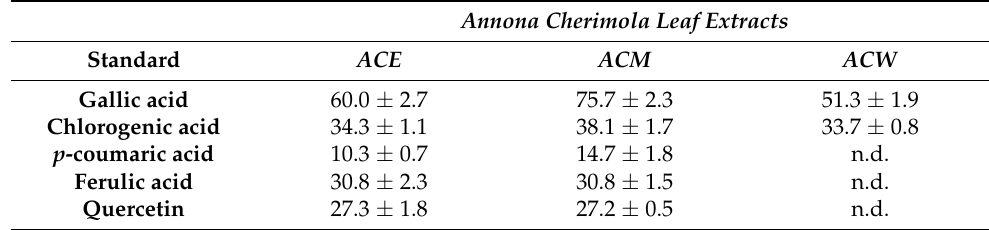
Table 3. Content of phenolic compounds in the A. cherimola leaf extracts (mg 100 g − 1 of dry extract). Annona Cherimola Leaf Extracts Standard ACE ACM ACW Gallic